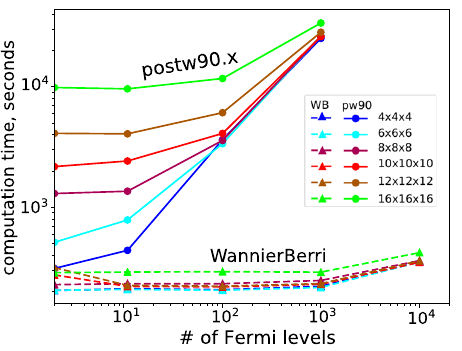
Fig. 4 Computational time for scanning multiple Fermi levels. Time for calculations with WB (dashed lines) and postw90.x (pw90, solid lines) are shown for different ab initio grids. MDRS method and symmetries are disabled